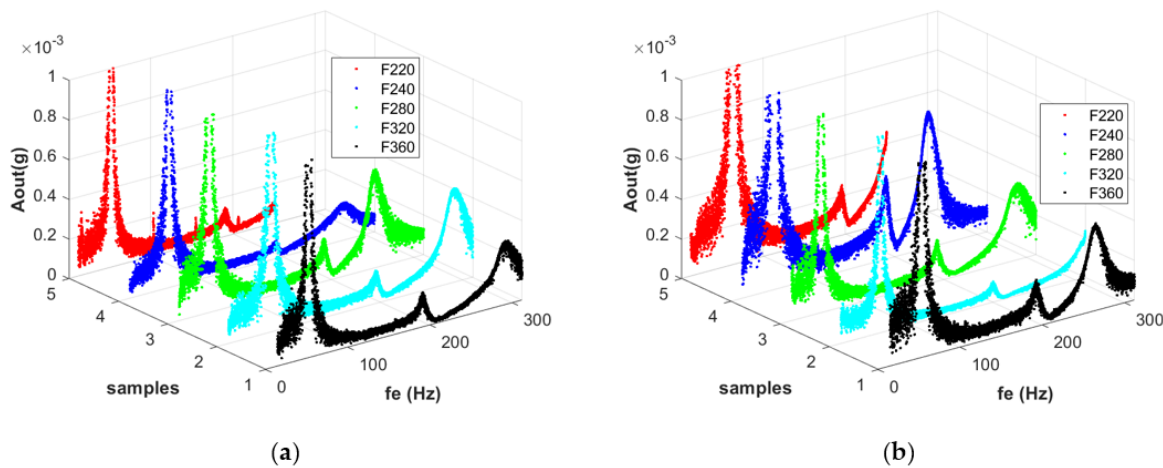
Figure 3. Dynamic response of the beams for the analyzed grains at a concentration of 5% of modifier ( a , b ) a concentration of 15% of modifier for all coarse-grained alumina.